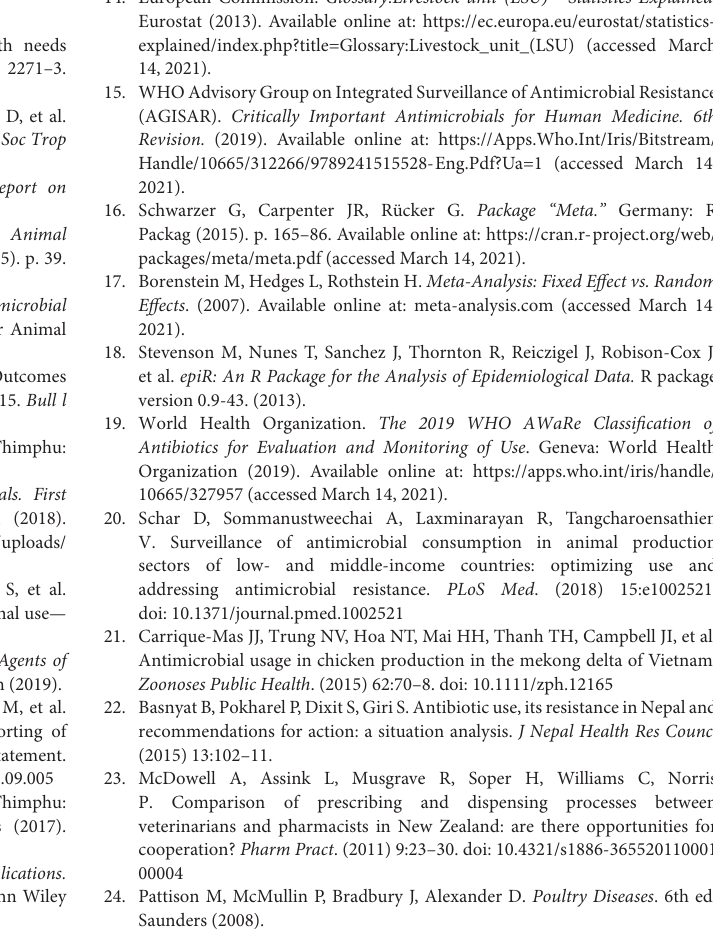
Supplementary Figure 1 | Top 5 diagnosis most frequently treated with antibiotics and associated antibiotic class prescription. Antibiotics classes are colored according to the AWaRe index ; green: access ; amber: watch ; gray : unclassified . ∗ and ∧ were separated from their classes as these drugs have different classification. Unsp. wound, unspecific wound; miscellaneous, unspecific signs including swollen, stress, and unconnected terms including “preventive” and “no diagnosis”. Supplementary Figure 2 | Frequency of diagnoses found in consultation records (treated and not treated with antibiotics) grouped by syndrome or system affected. GI, gastrointestinal afflictions, including diarrhea and vomits; Infectdiseases, infectious diseases including strangles and FMD; int-ext-parasite, internal or external parasites; other, unspecific signs including swollen, sore, or prolapse without further specification, poisoning, unconnected terms including “preventive,” “no diagnosis,” and illegible records; systemic, weakness and inactivity, anorexia, or ill-thrift. Supplementary Figure 3 | Frequency of prescription of antibiotic classes in the consultation records